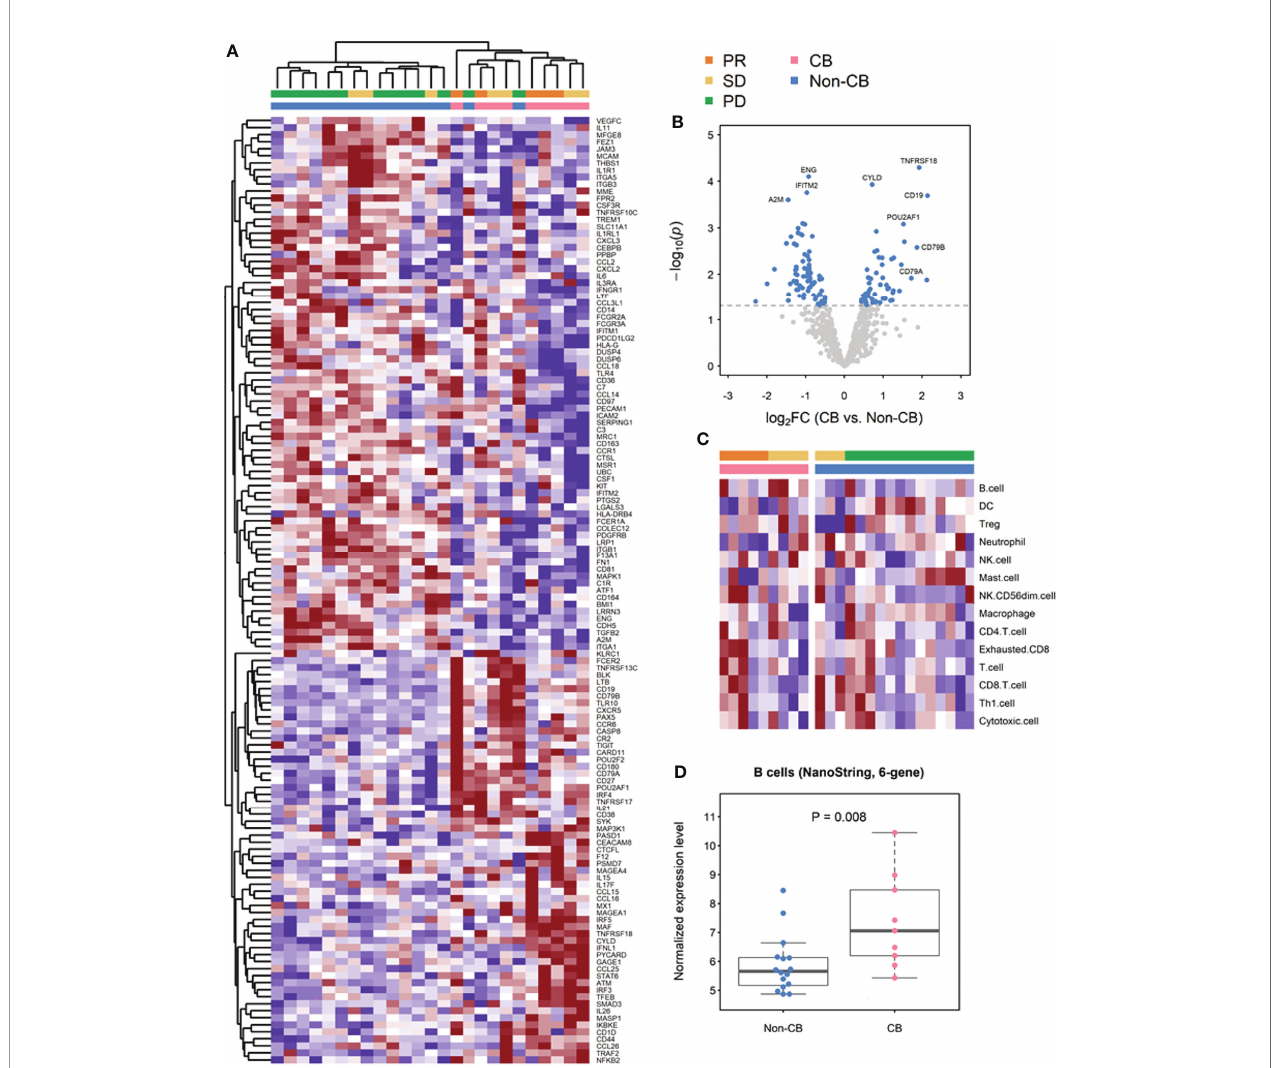
FIGURE 2 | Transcriptional analyses of formalin- fi xed paraf fi n-embedded (FFPE) archival tumor specimens from patients with advanced esophageal squamous cell carcinoma (ESCC) treated with anti-PD-1 or anti-PD-L1-based immunotherapy. (A) Unsupervised hierarchical clustering of differentially expressed genes (DEGs) by using NanoString platform analysis. (B) Volcano plot depiction of DEGs based on clinical bene fi t (CB). (C) Supervised clustering of ESCC FFPE archival tumor specimens based on CB (n = 16 non-CB and 9 CB), displaying nCounter scores. (D) Log 2 -transformed normalized expression levels of B cells based on nCounter scores clustered by CB. (DC, dendritic cells; NK cells, natural killer cells; PR, partial response; SD, stable disease; PD, progressive